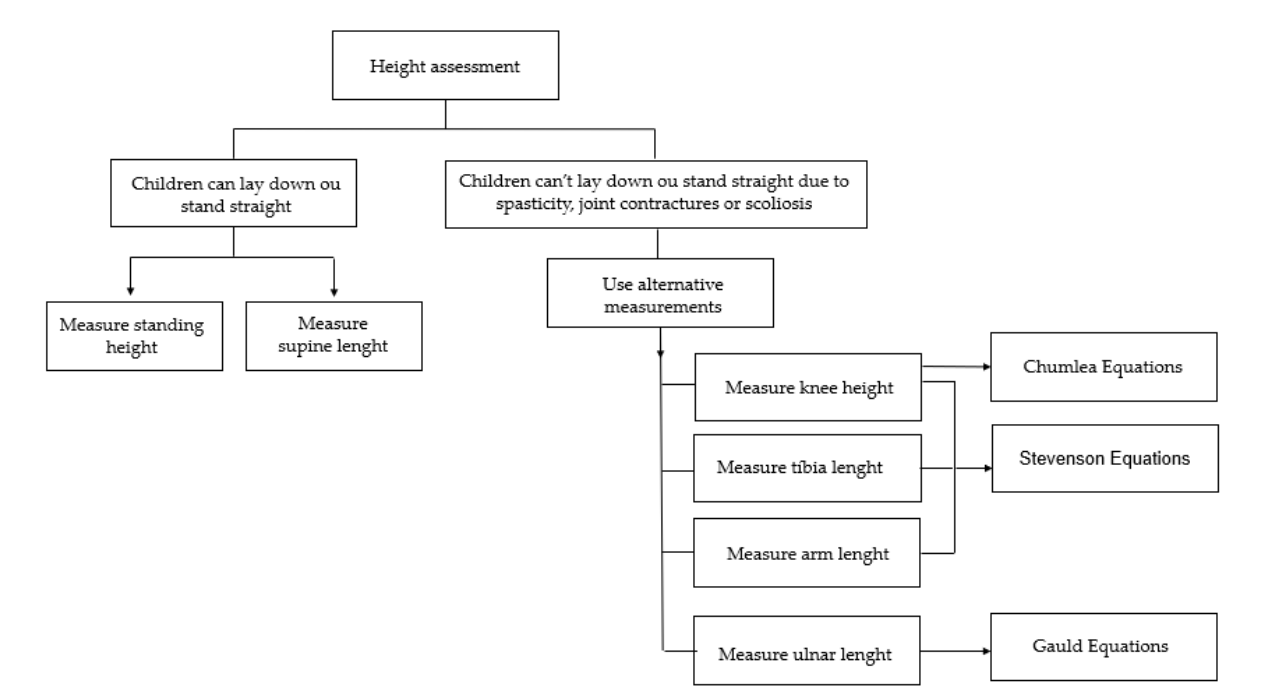
Figure 2. Height assessment using conventional and alternative methods. Table 2. Equations to estimate weight and height in children with